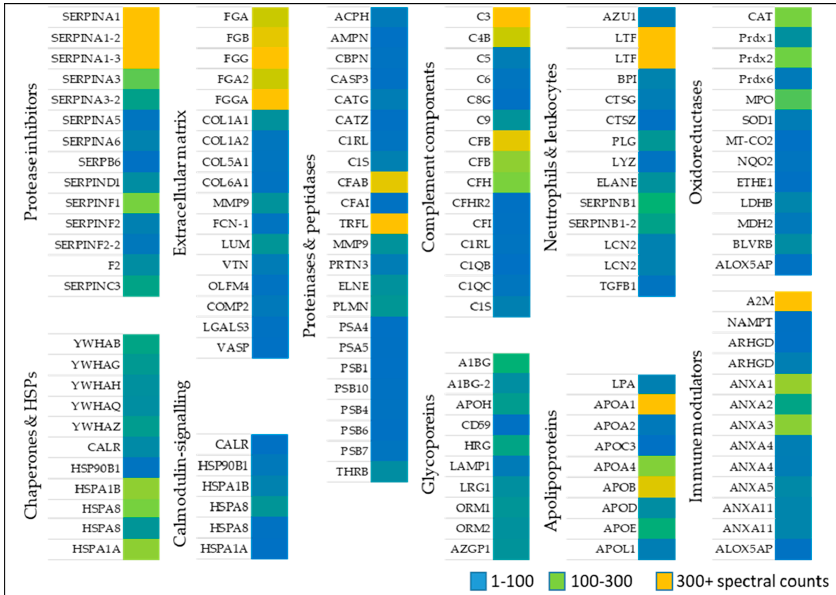
Figure 2. Relative abundance of high confidence proteins as determined in the pooled wound fluid samples by liquid chromatography/mass spectrometry spectral counts. Table 5. Extracellular matrix proteins in wound fluids.